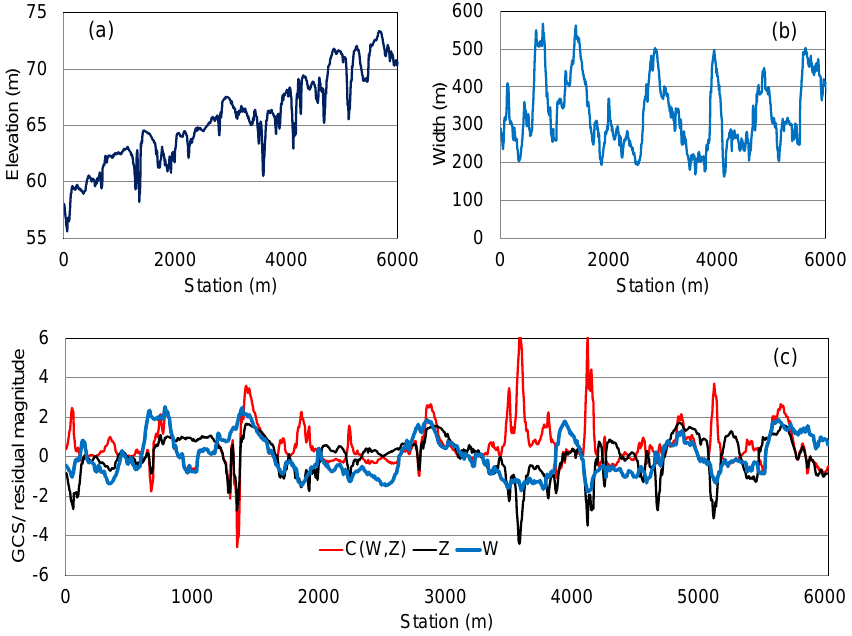
Figure 2. Raw bed profile (a) and flow width (b) series for 283.2m 3 s − 1 . After detrending and standardizing, values of Z (black line in c ) and W (blue line in c ) are multiplied together to compute C ( ZW j ) (red line in c ). The whole series of C ( ZW j ) is the